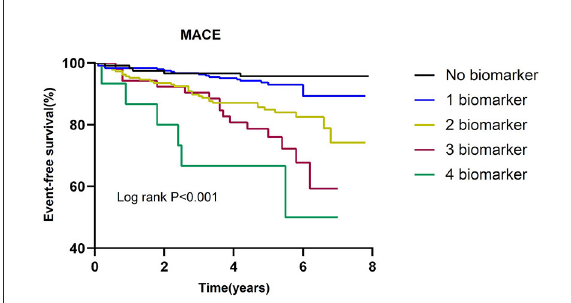
FIGURE2 Kaplan-Meier survival curve for MACE according to number of elevated